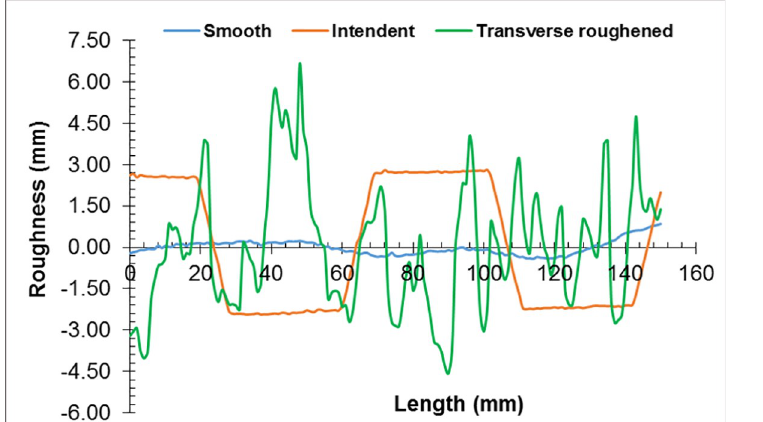
Fig 5. Surface roughness profile at the top surface of the concrete